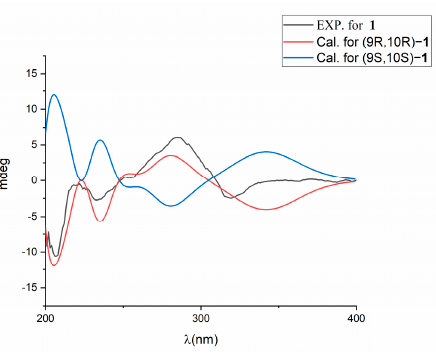
Figure 3. The key ROESY correlations of compounds 1 – 2.